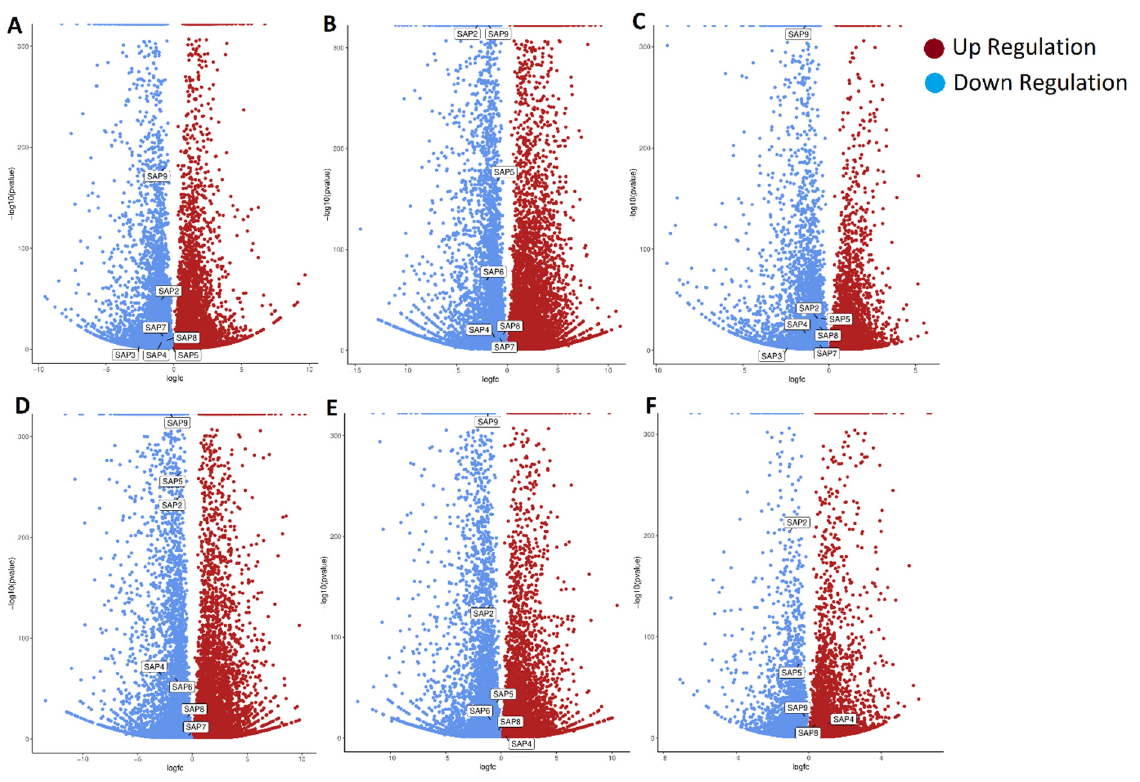
Figure 10. Differential gene expression of fruitlets in almonds. Volcano plots of differential expression of PdSAP genes is shown at developmental stage at 12 ( A ), 17 ( B ), 22 ( C ), 27 ( D ), 32 ( E ), and 37 ( F ) days after flowering in almonds fruitlets.